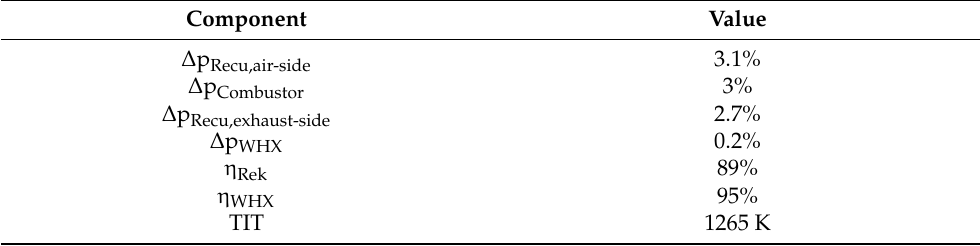
Table 1. Excerpt of MGT model input parameters derived from experimental data of the DLR test rig at 240 krpm (full load